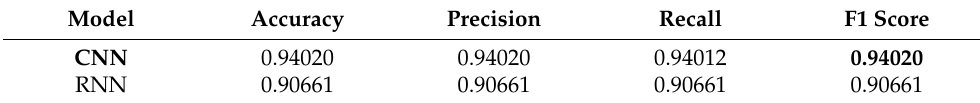
Table 11. The evaluation comparison of each model for sentiment classification. Model